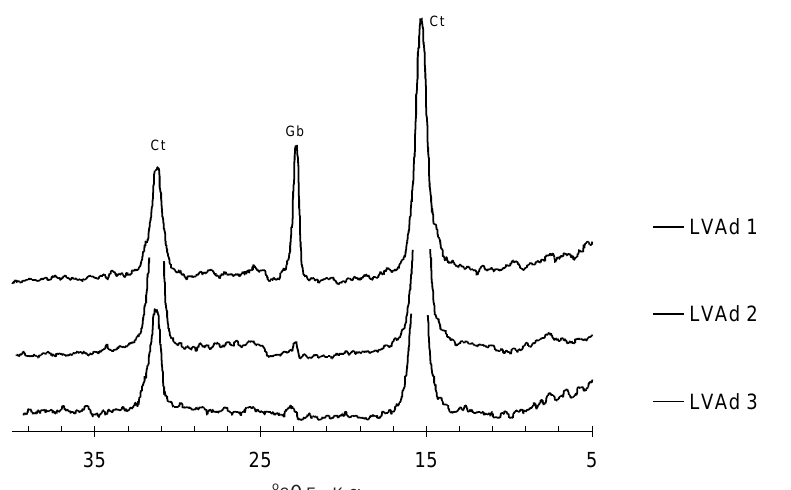
Figura 4. Difratogramas de Raios-X da fração argila desferrificada dos Latossolos estudados (lâminas de argila orientada). Ct – Caulinita; Gb – Gibbsita.